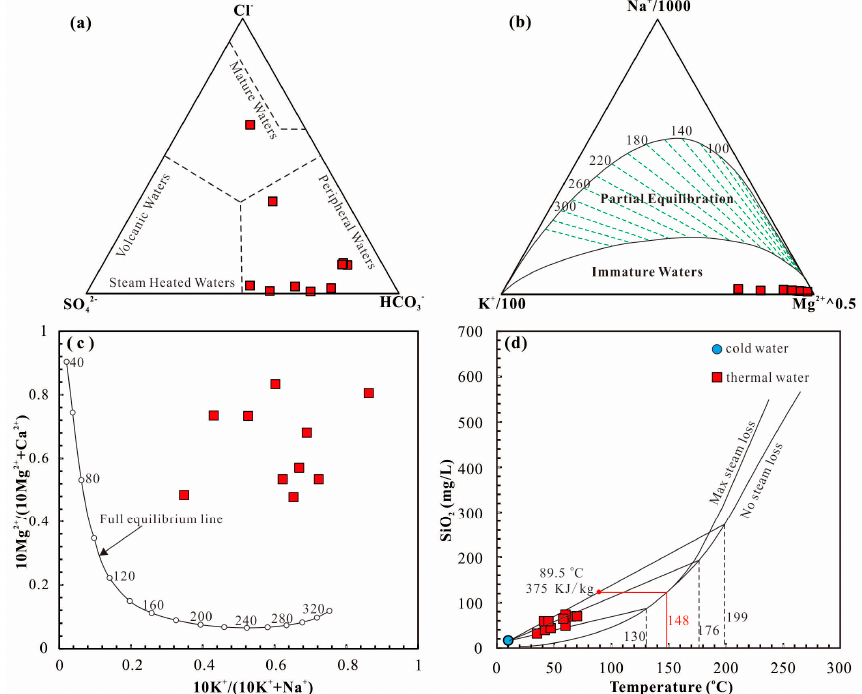
Figure 10. ( a ) Giggenbach Cl − -SO 4 2 − -HCO 3 − and ( b ) Na-K-Mg ternary diagrams; ( c ) Mg 2+ /(Mg 2+ + Ca 2+ ) versus 10K + /(10K + + Na + ) diagram; ( d ) SiO 2 versus temperature diagram. Silica concentration of cold water is the average values of groundwater samples in Table S1.